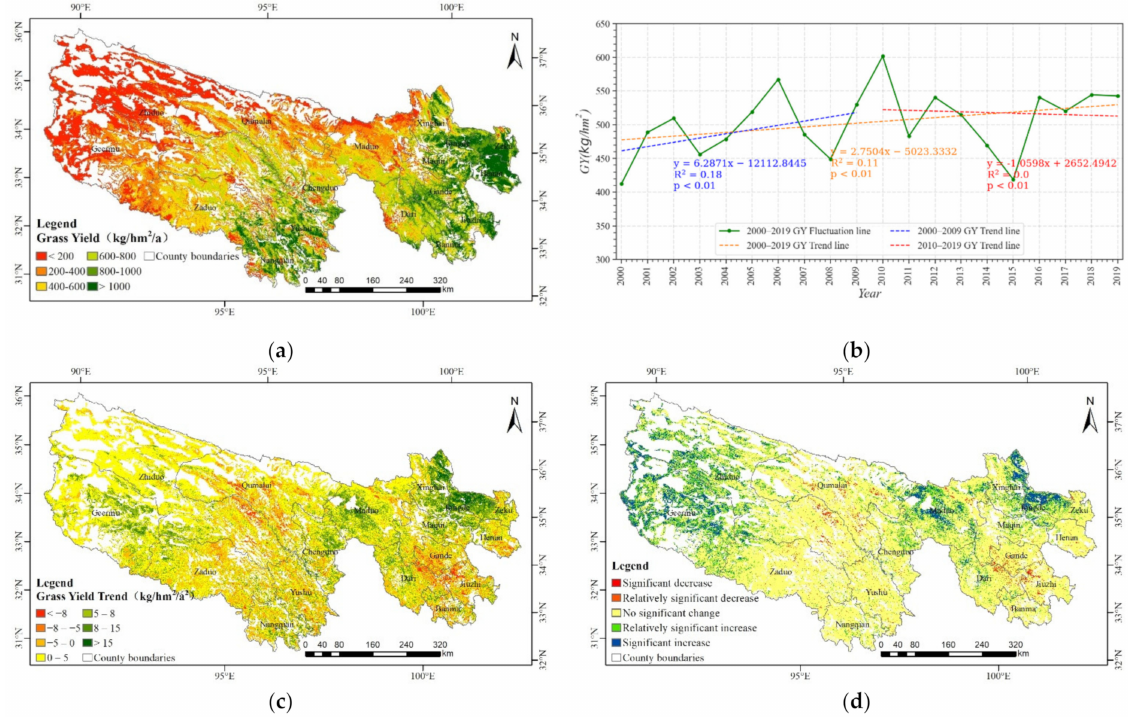
Figure 9. Spatial distribution of average annual grass yield ( a ), inter-annual changes ( b ), change trend ( c ), and significance ( d ) of ecosystems in the TRHR from 2000 to